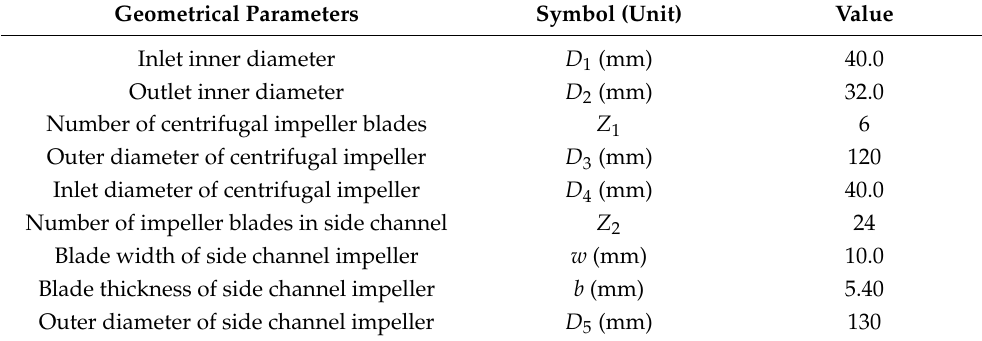
Table 1. Geometric specifications of key components of the multistage side channel pump.